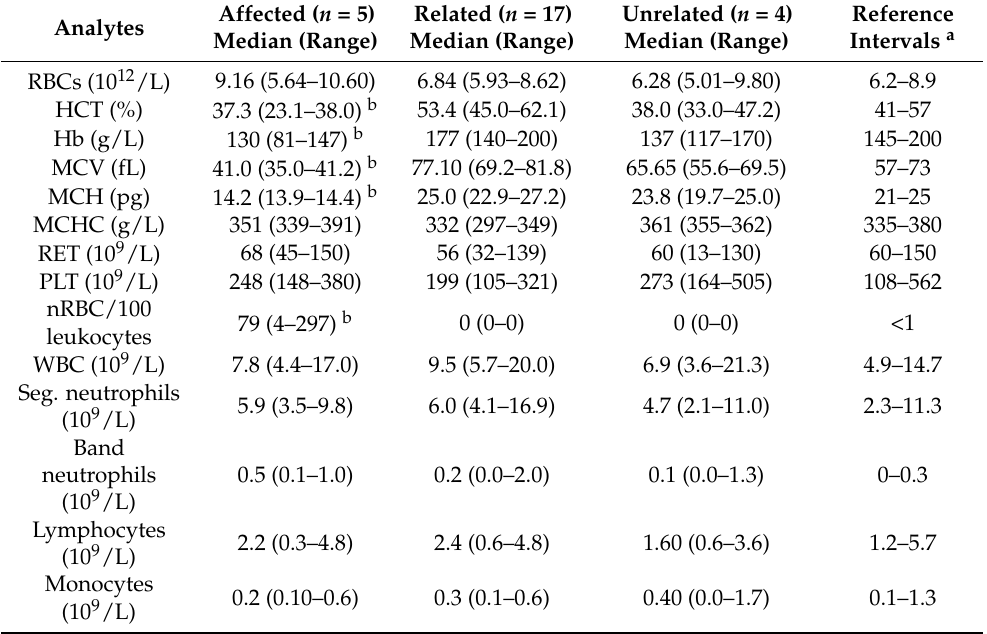
Table 1. Hematology results for affected, related, and unrelated ESSP dogs from Sweden with dyserythropoietic anemia and myopathy syndrome.